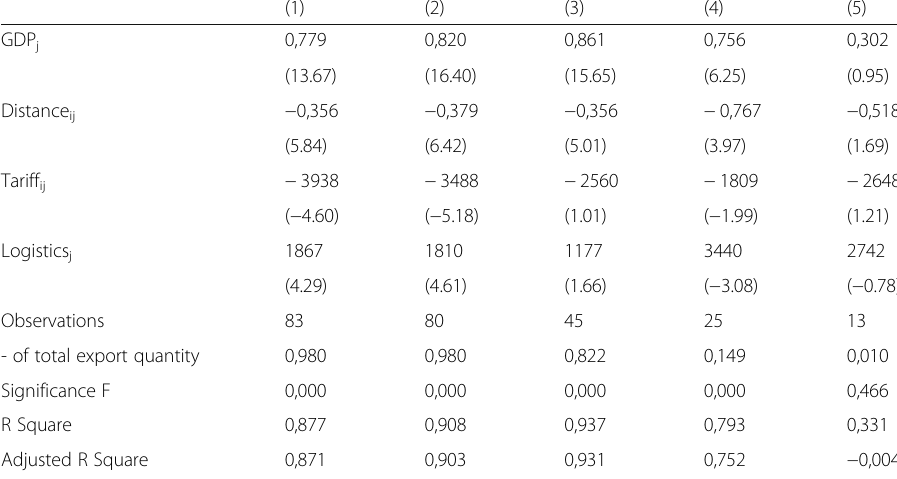
Table 4 Diagnostic tests based on